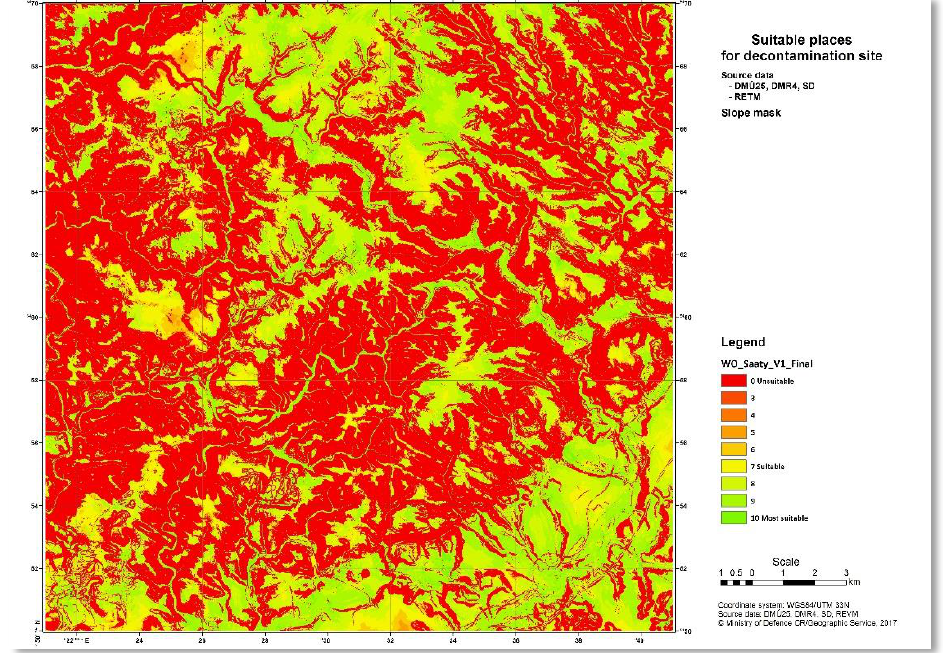
Figure 5. Final cost map of landscape potential for DS deployment.